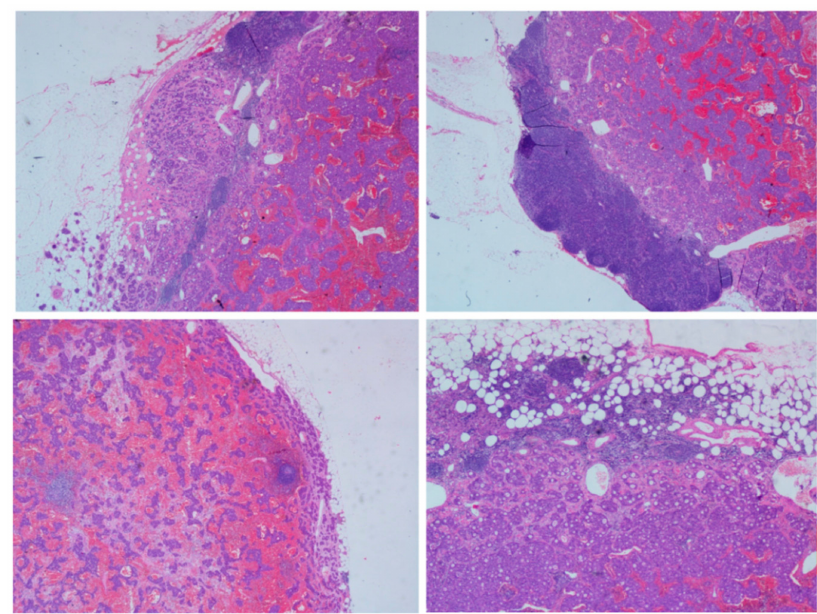
Figure 1. Low-power view of pancreatic neuroendocrine tumor by immunostaining.